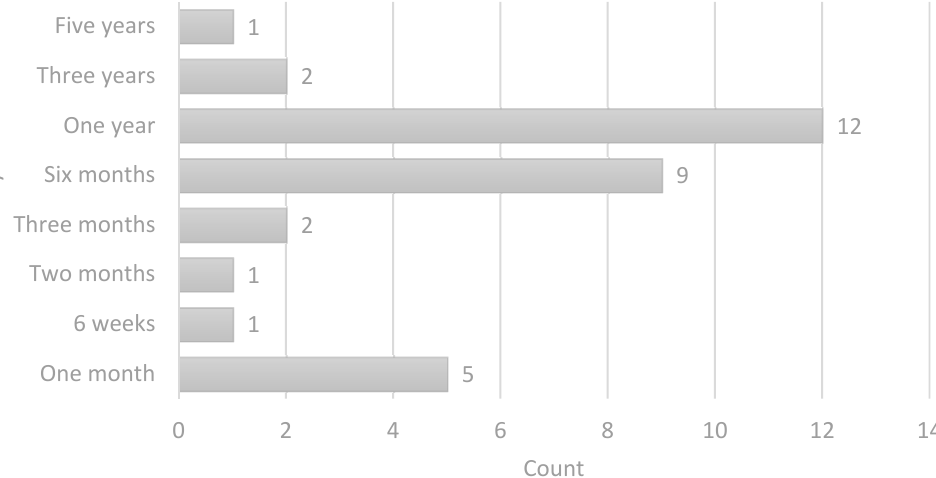
Figure 5. Time impact (delay) of legal challenges.